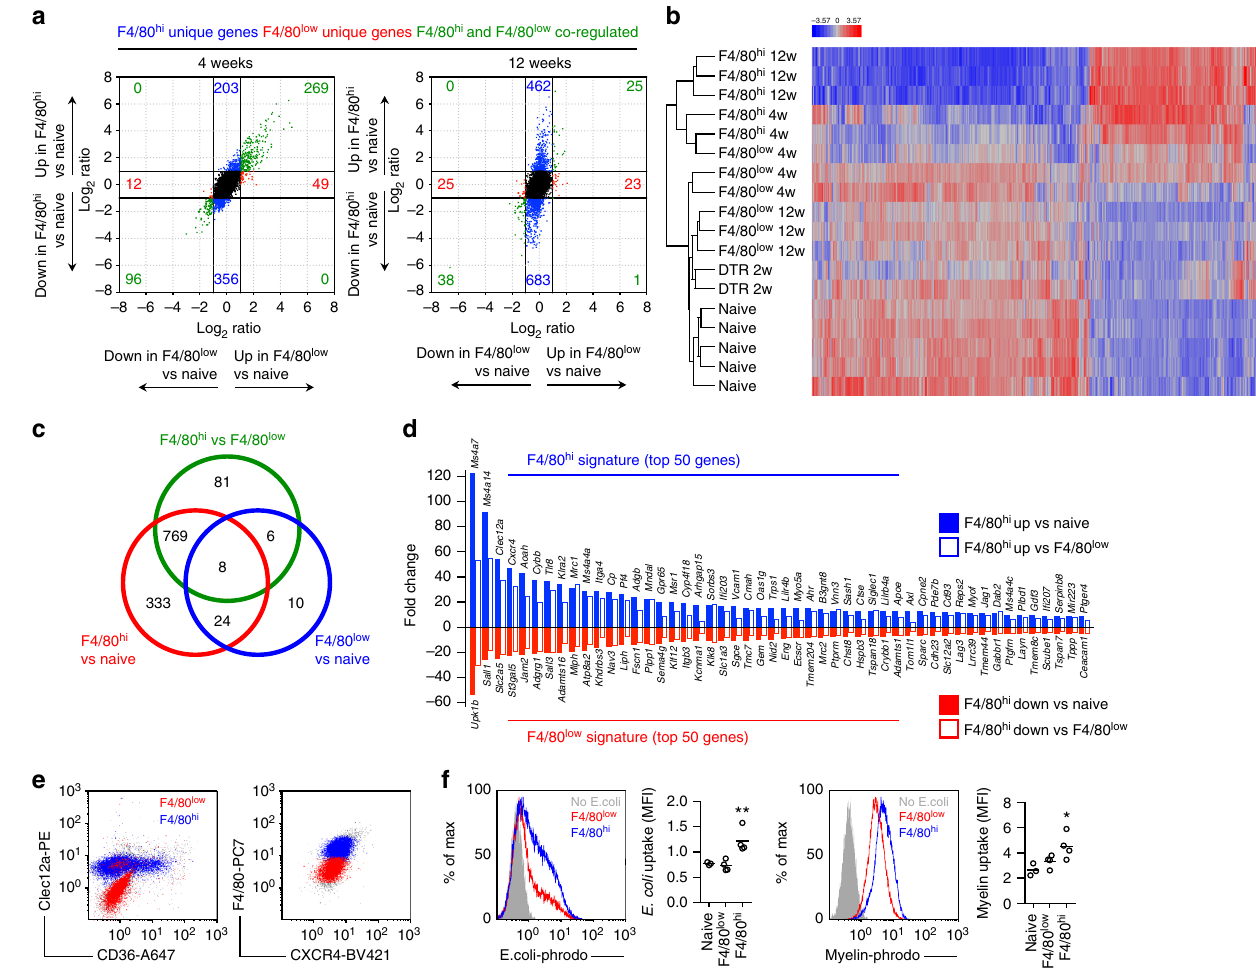
Fig. 5 Monocyte-derived macrophages are transcriptionally and functionally distinct from resident and proliferating microglia. a FC/FC plots comparing differential gene expression in F4/80 low and F4/80 hi subsets with naive microglia, respectively, after 4 and 12 weeks. b Heat map ( z -scores) of 1137 genes differentially expressed (>2 fold change both directions, adj. p < 0.05) between naive microglia and F4/80 hi 12 week subsets. c Venn diagram of differential gene expression between naive microglia, F4/80 low and F4/80 hi subsets at 12 weeks. d F4/80 hi and F4/80 low gene signature; Top 50 up/down-regulated genes in F4/80 hi macrophages compared to both naive microglia and F4/80 low microglia at 12 weeks. e Clec12a, CD36, CXCR4 surface expression in F4/80 low and F4/80 hi subsets analyzed by fl ow cytometry. Gated on CX3CR1 hi CD11b + cells from Cx3cr1 CreER/ + R26 DTA/ + mice > 5 weeks after TAM. f Phagocytosis of pHrodo Red E. coli microparticles and pHrodo Red-labeled myelin in CD11b-enriched CNS cells, stained with F4/80 to gate on CX3CR1 + F4/80 low (red) and CX3CR1 + F4/80 hi (blue) subsets in Cx3cr1 CreER/ + R26 DTA/ + mice 5 weeks after TAM. Naive CX3CR1 + F4/80 low microglia were used as control. Lines represent mean values. * p < 0.05, ** p < 0.01 by Student ’ s paired two-tailed t -test (comparing F4/80 low and F4/80 hi